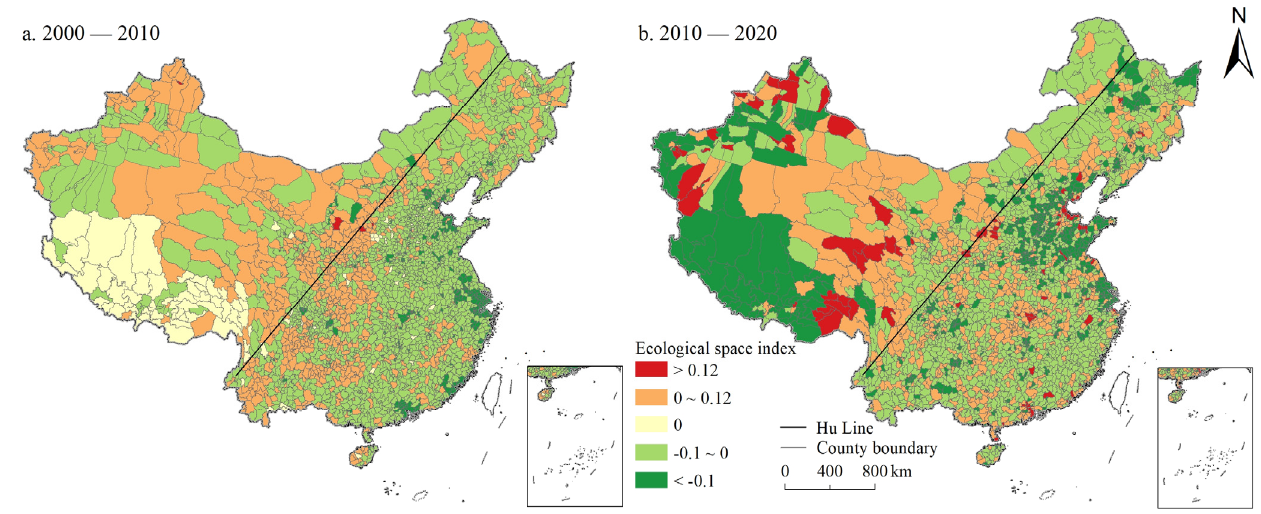
Figure 3. Spatial distribution of ESI changes in China during 2000–2020.